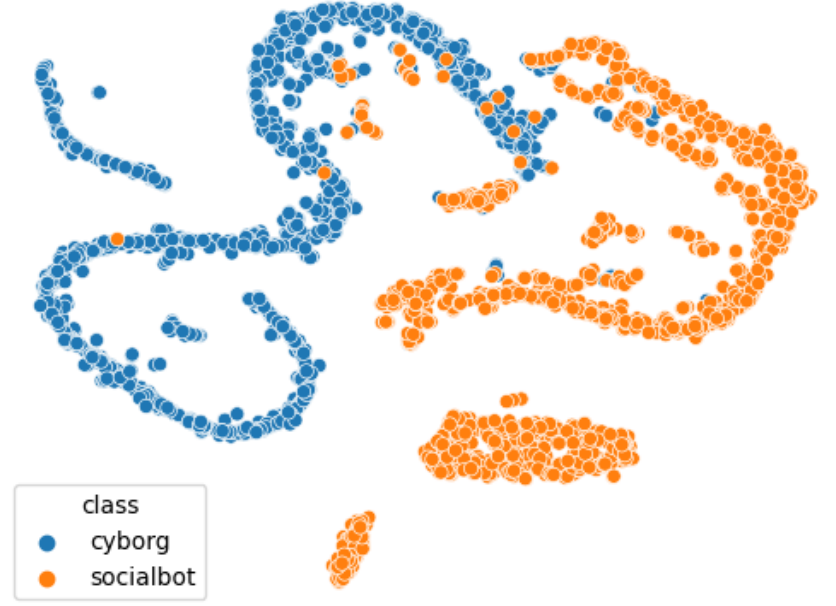
Figure 12. 2-D visualization of our high dimensional dataset, limited to user features for cyborgs and social bots. The distinction between these two classes is